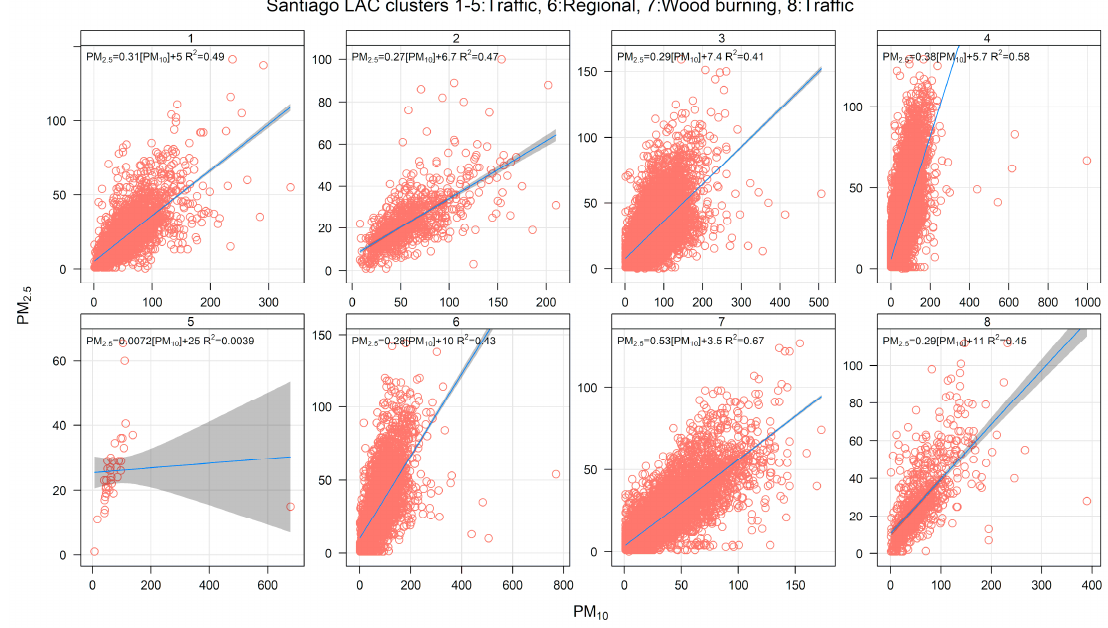
Figure 15. PM 2.5 –PM 10 scatter plot by cluster, for an eight-cluster solution for Santiago.